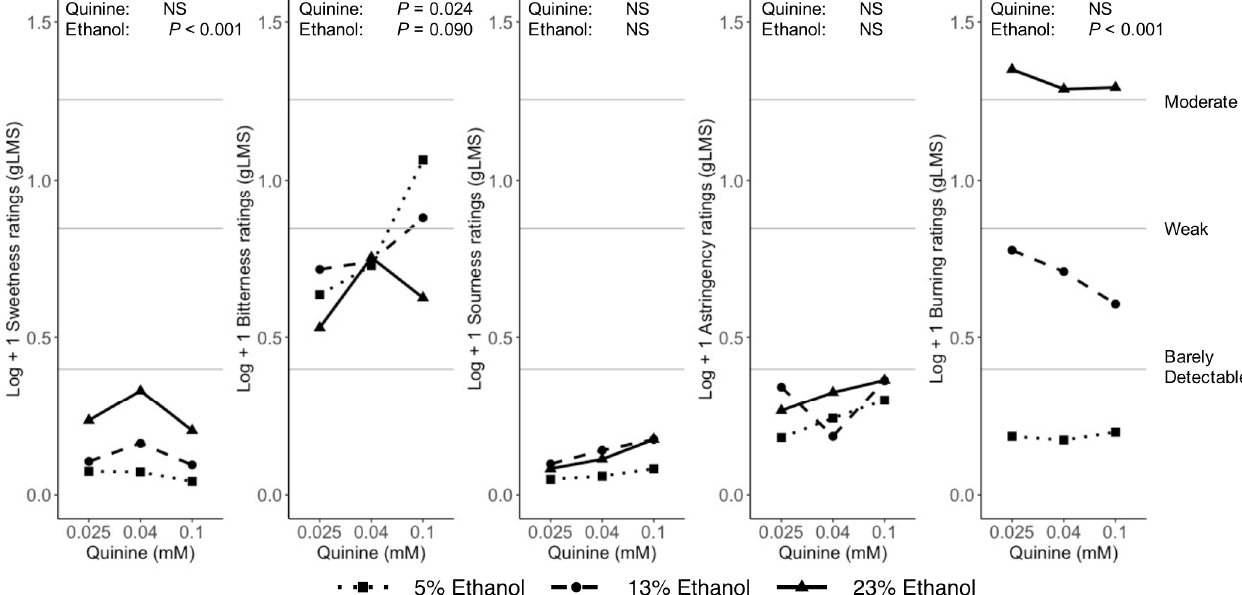
Figure 5. Mean ratings of sweetness, bitterness, sourness, astringency and burning/tingling in the binary solutions of ethanol (5%, 13%, 23% v/v ) and quinine (0.025 mM, 0.040 mM, 0.100 mM). Significant differences are indicated from the p -values above each graph (NS = not significant). A full summary of the model including the effect of thermal taste status and 2-way interactions is included in Table S2.